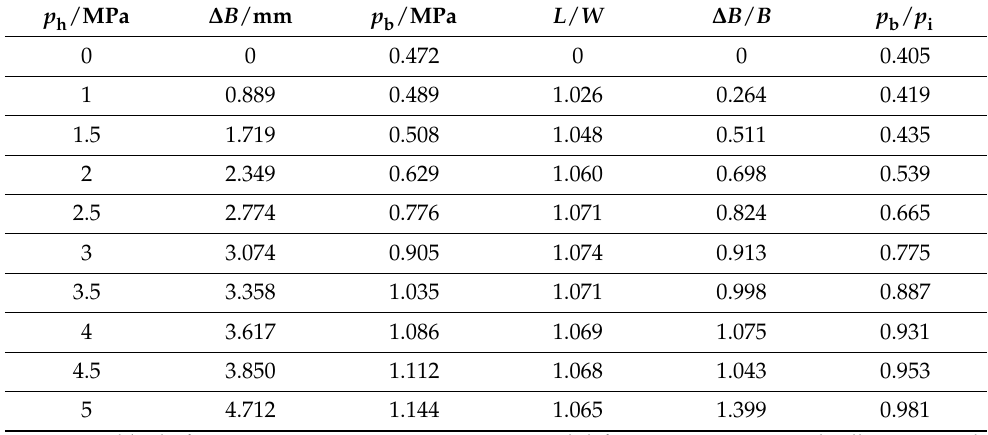
Figure 5. Cross-sections (blue solid lines) of hydroformed toroidal pressure hulls after spring back subjected to various hydroforming pressures. Black solid lines correspond to discrete octagonal cross-sections before hydroforming in Figure 1; red lines correspond to continuous circular cross-sections with perfect geometry. Table 3. Maximum vertical deformations and external collapse strengths of toroidal pressure hulls under various internal hydroforming pressures.